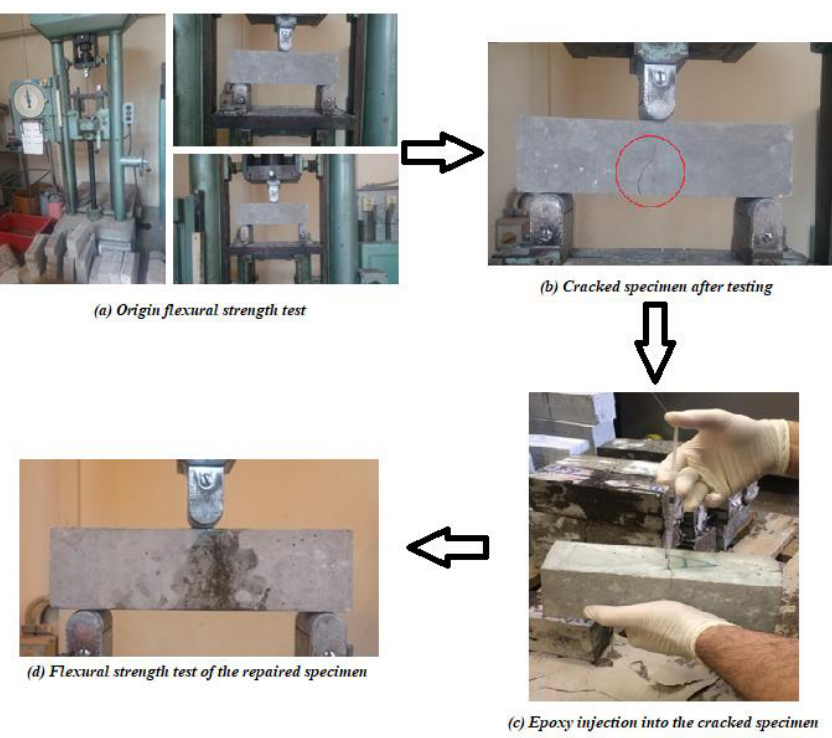
Figure 4. The used procedure for repairing cracked fiber concrete by epoxy injection .